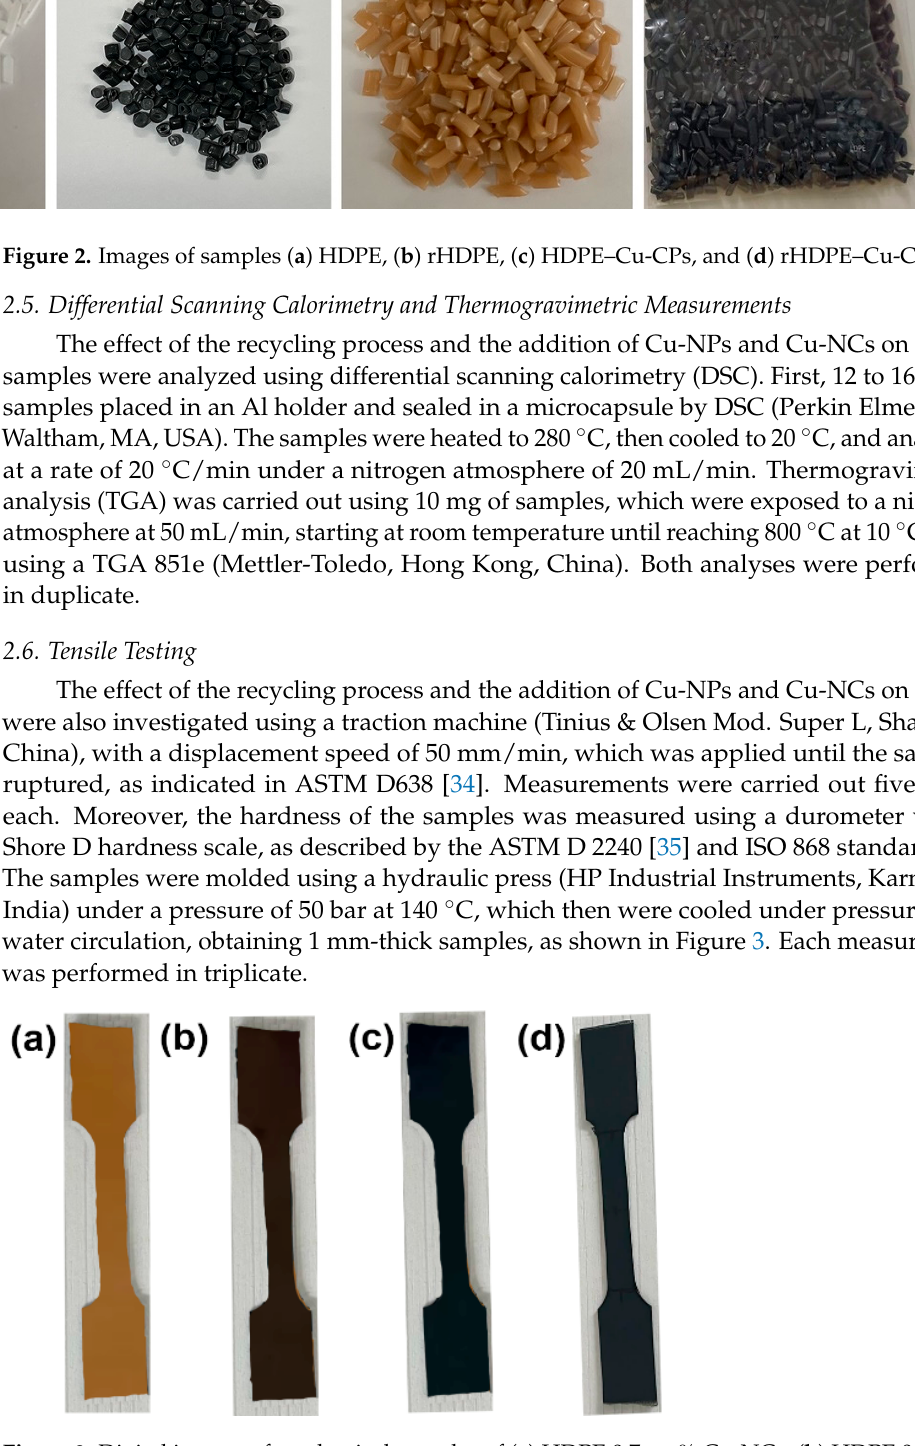
Figure 2. Images of samples ( a ) HDPE, ( b ) rHDPE, ( c ) HDPE–Cu-CPs, and ( d ) rHDPE–Cu-CPs.